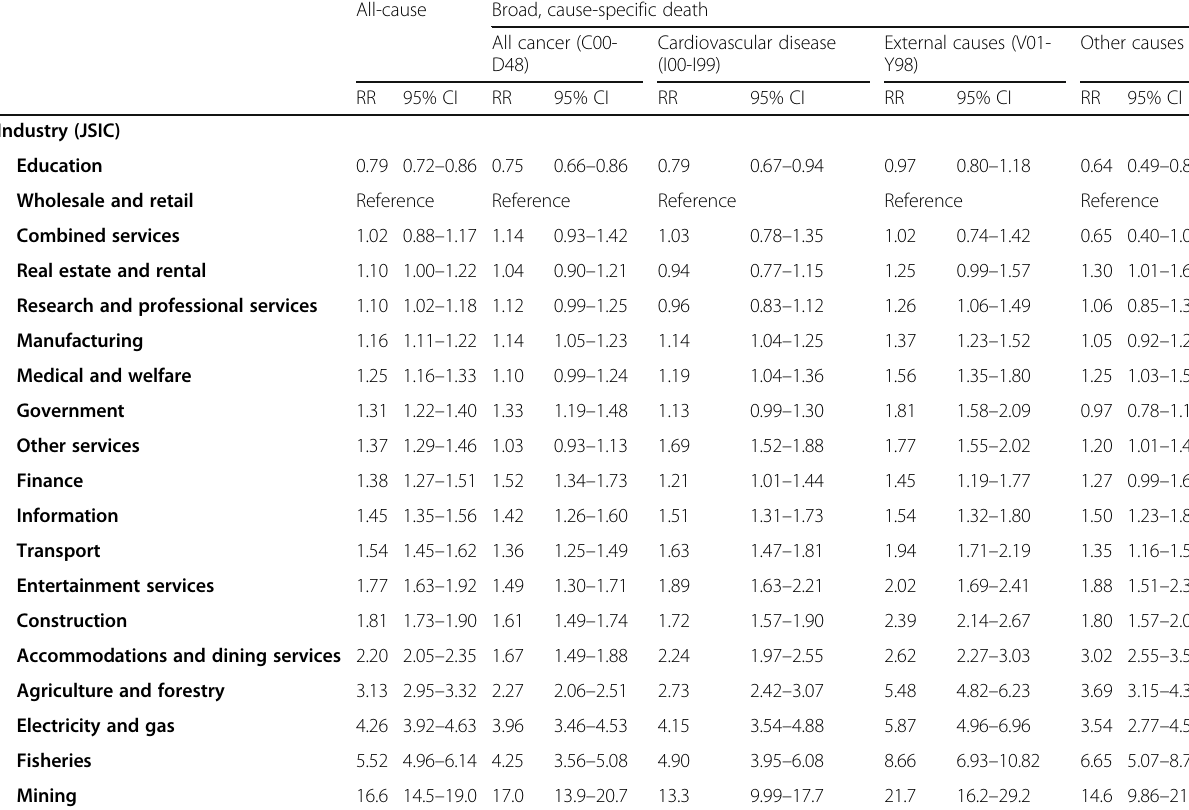
Table 4 Mortality rate ratios by industry in Japan during the 2015 fiscal year, males aged 25 – 64